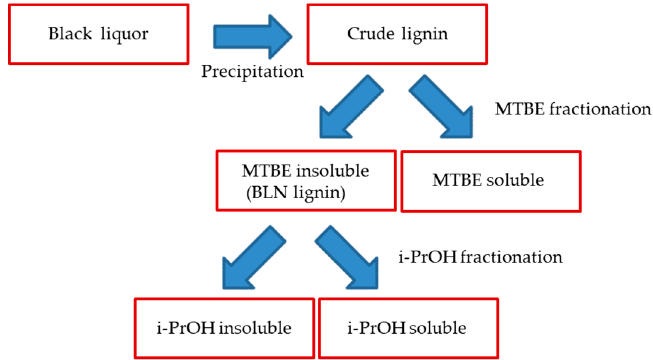
Scheme 1. Scheme of the lignin fractionation.